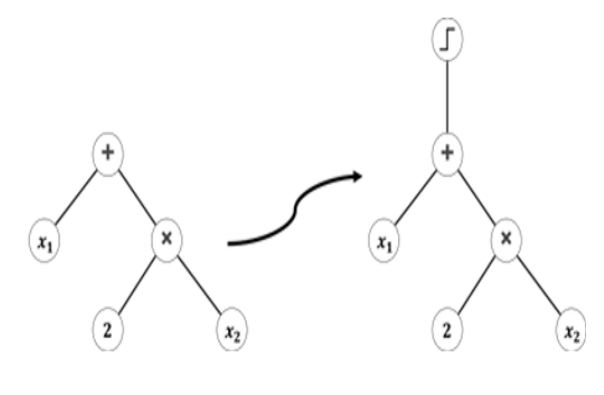
Table 2. Parameters of the GP